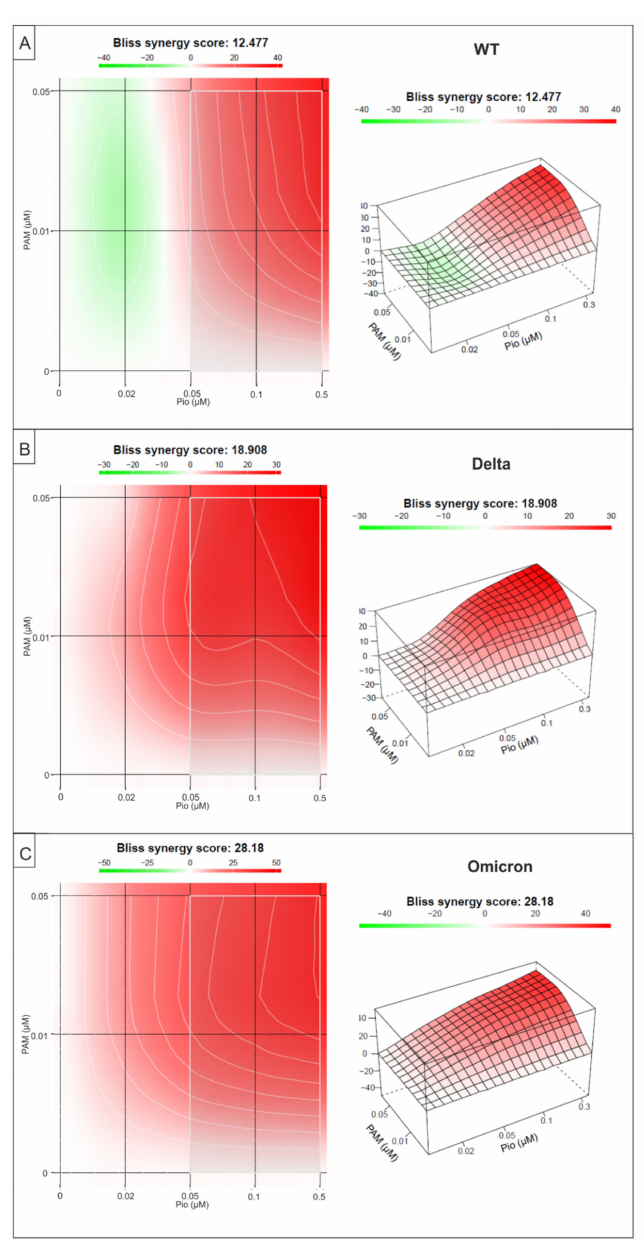
Figure 8. Interaction profile of PAM and Pio for determining the synergy in the inhibition of